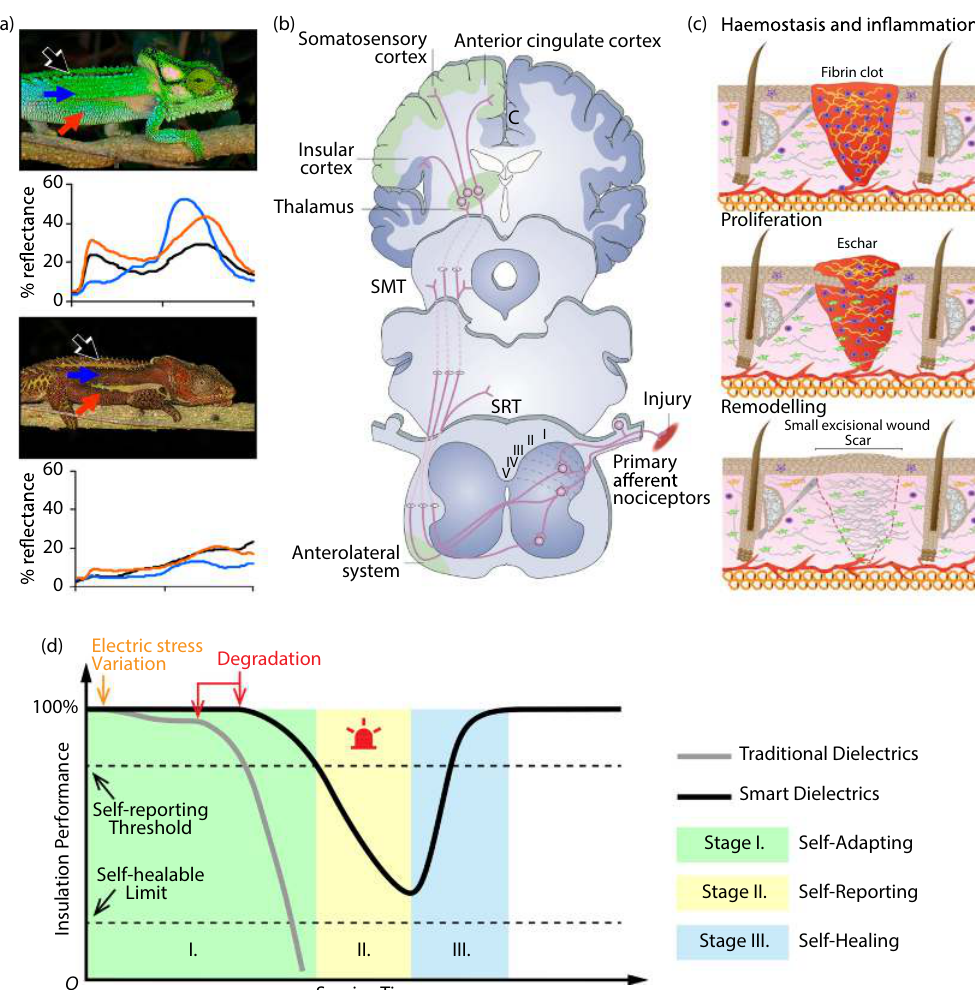
Fig. 1 Inspirations for designing smart dielectrics with biomimetic and autonomous functions. ( a ) Changes in the skin color and reflective spectrum of a chameleon (reprinted with permission from ref. [18], © 2008 Stuart-Fox and Moussalli). ( b ) Schematic of afferent pathways underlying the sensation of pain (reprin- ted with permission from ref. [15], © 2004 Nature Publishing Group). ( c ) Process of skin wound healing: haemostasis and inflammation, proliferation and remodeling (reprinted with permission from ref. [16], © 2019 Springer Nature). ( d ) Life cycle control of biomimetic smart materials for next-generation electrical